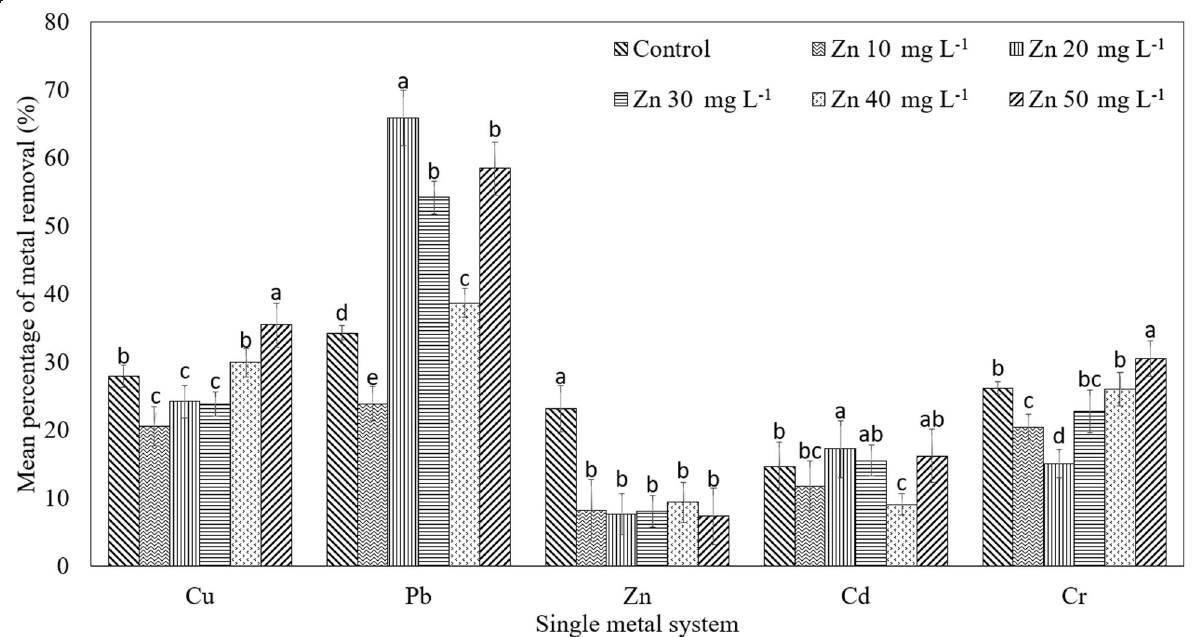
Fig. 6 Mean percentage (%) of metal (Cu, Pb, Zn, Cd, Cr) removal by EPS derived from single culture of B. cereus subjected to various concentrations of Zn to induce metal stress (10, 20, 30, 40, 50 mg L − 1 ) during cultivation. Metal removal test was performed in single metal systems. Means with the same letters within the metal type indicate no significant difference according to Tukey comparisons ( p < 0.05). Bars indicate standard deviation of